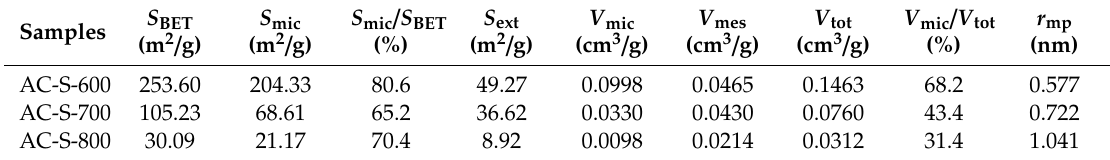
Table 1. Physical properties of AC samples from N 2 adsorption at 350 ◦